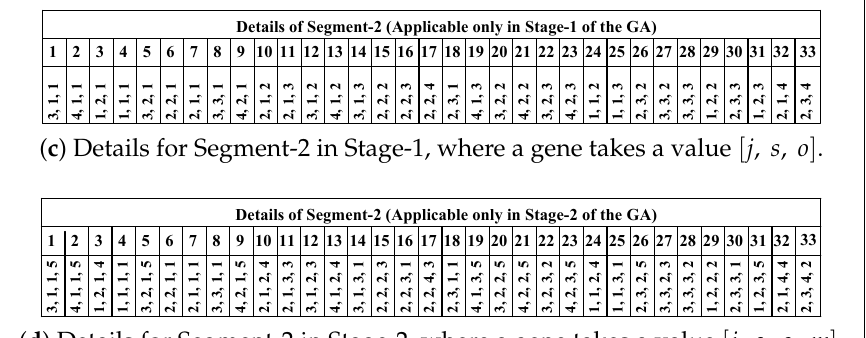
( d ) Details for Segment-2 in Stage-2, where a gene takes a value [ j , s , o , m ] . Figure 1. Solution